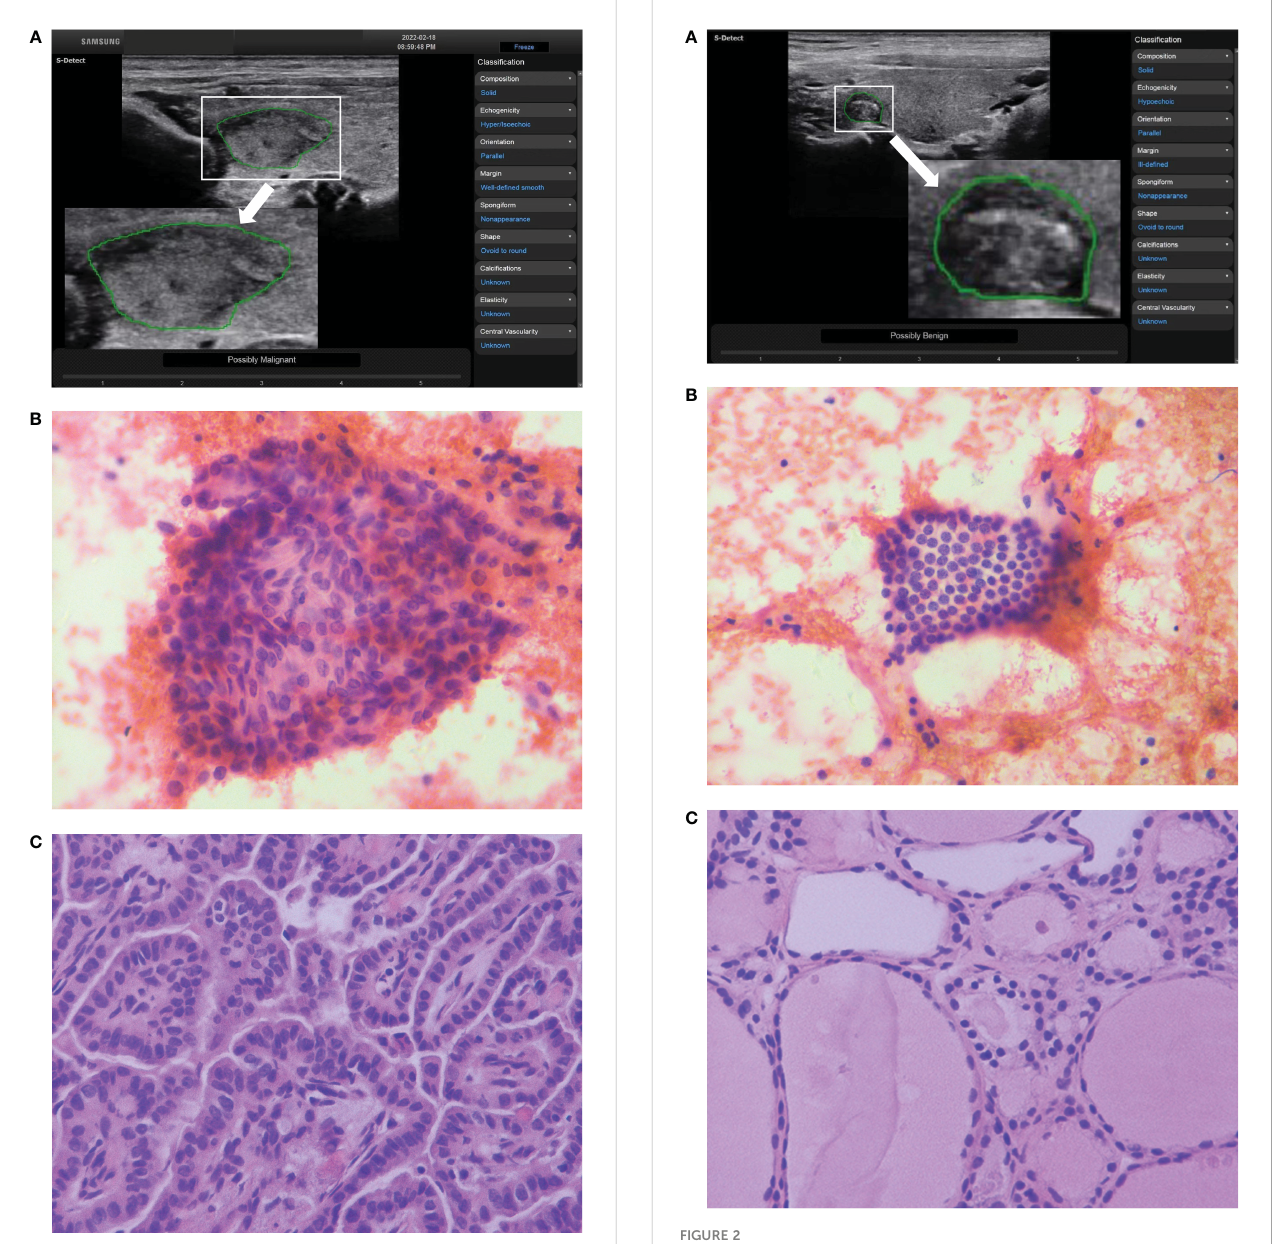
FIGURE 2 The ultrasound features of a thyroid nodule in a 32-year-old woman were solid, hypoechoic, wider than tall, ill-de fi ned margin and punctate echogenic foci. S-Detect indicated “ Possibly Benign ” (A) . However, the ACR TI-RADS was TR5 with 7 points, and the C-TIRADS was TR4C with 3 points. It was considered to be a malignant nodule. The nodule was classi fi ed as Bethesda III category after fi ne-needle aspiration (B) (HE staining; magni fi cation ×400). And the fi nal pathological result suggested nodular goiter (C) (HE staining; magni fi cation